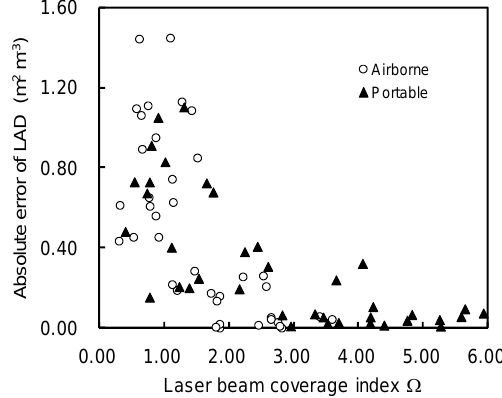
Figure 5: Relationship between the laser beam coverage index Ω (= A beam × N exp(– K LAI cum ); Eq. 3) and the absolute errors of LAD in all airborne and portable ground-based lidar measurements (Hosoi et al., 2010).